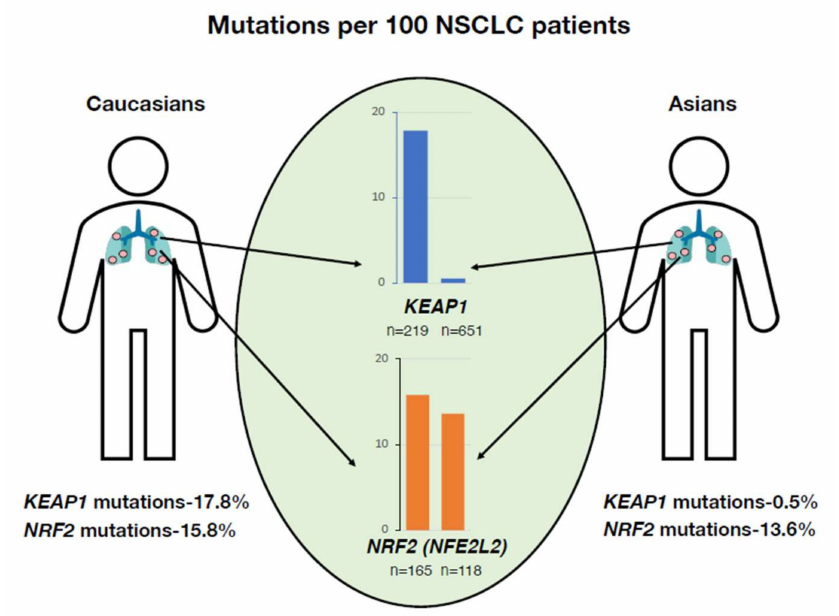
Figure 4. Ancestry-based disparities in KEAP1 mutations associated with non-small-cell lung car- cinoma (NSCLC). KEAP1 mutations in NSCLC are more frequently found in individuals with European ancestry than in those with East Asian ancestry. This discrepancy is not found for the NRF2 gene ( NFE2L2